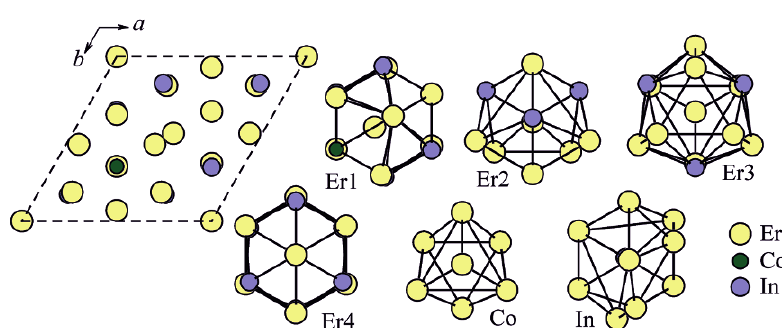
Figure 5. The projection of Er